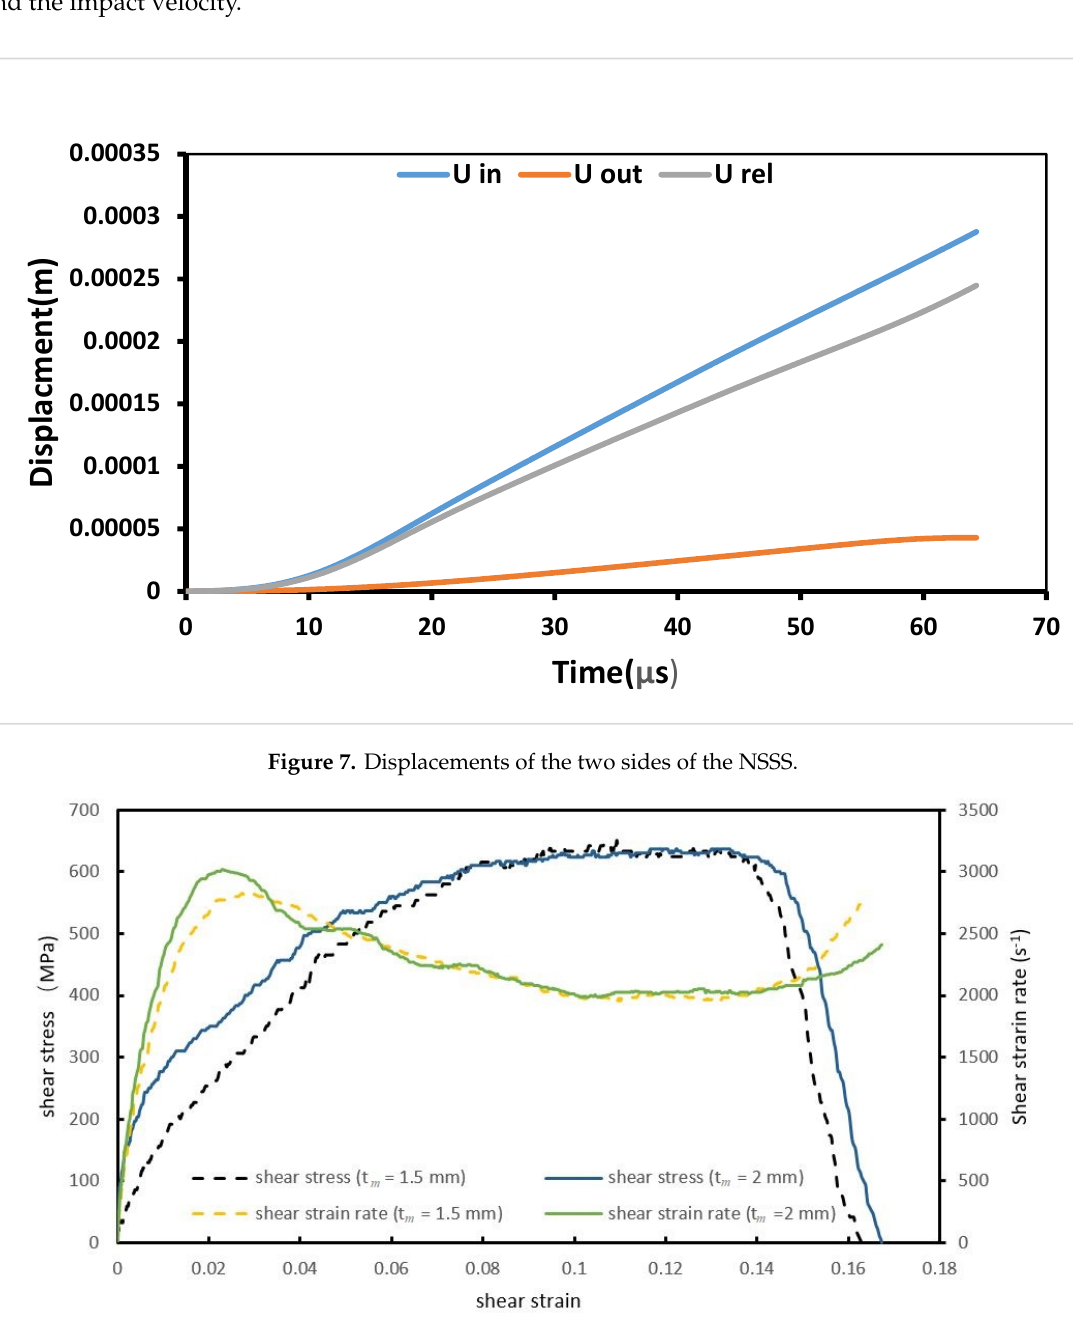
Figure 9. Three shear stress–strain curves of the NSSS under the same strain rate (900 s − 1 ). Figure 10 shows the shear stress–strain curves of the Ti6Al4V measured by the new shear sample under various shear strain rates. The shear stress increases with the strain rate. In all strain rates, the flow stress increases slightly with the shear strain. This finding is in good agreement with the result of other researchers [1,20,30]. Peries et al. [20] tested the dynamic behavior of the Ti6Al4V by different geometry of the hat shape sample. They mentioned, because of the complex stress distribution in the hat shape sample, interpretation of the test results is not straight forward. The important differences